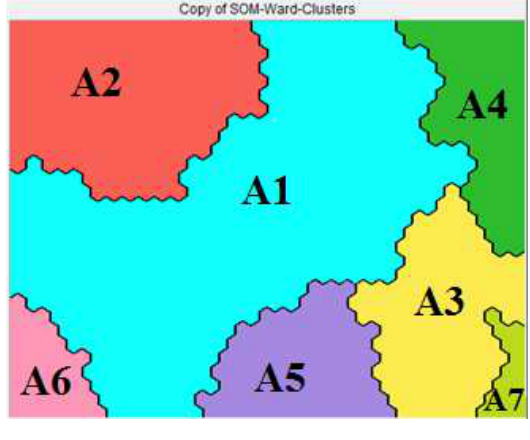
Figure 1. Cluster map